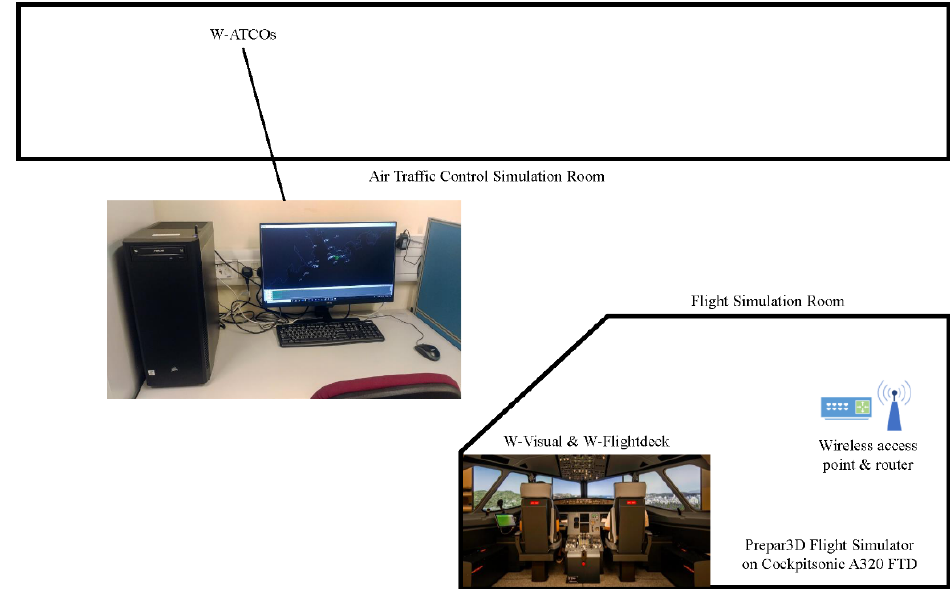
Figure 2. The physical layout of the system architecture.